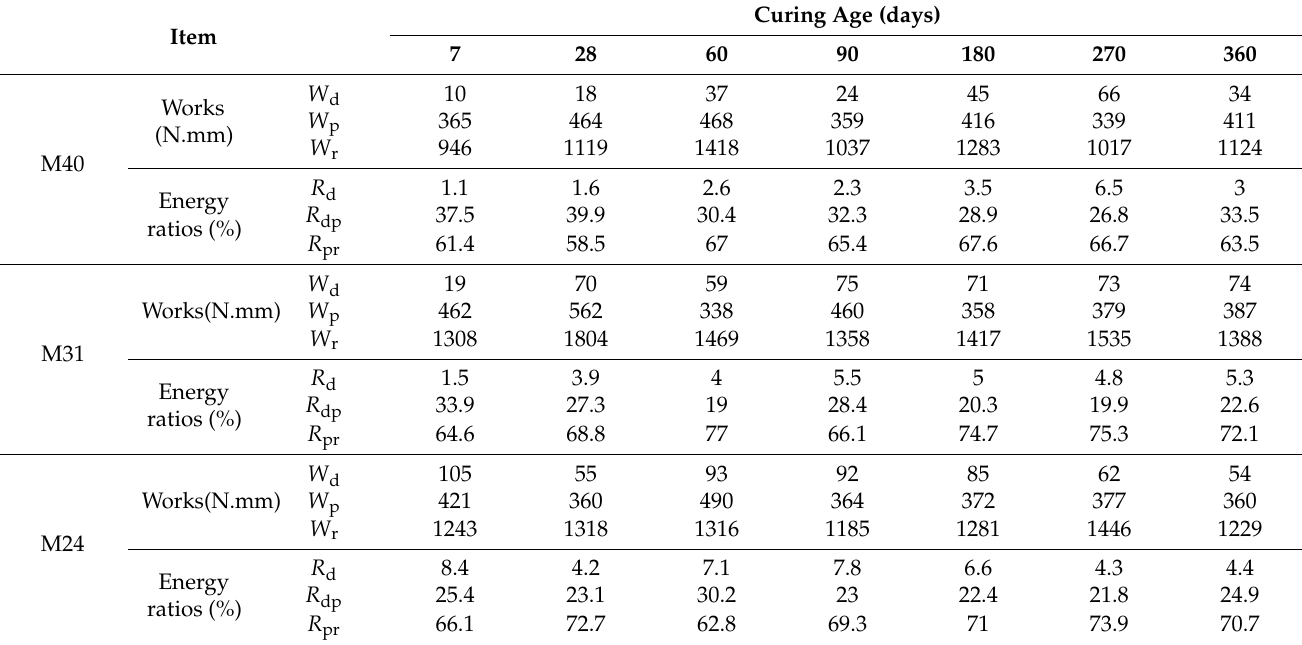
Table 6. Energy dissipation in the process of pull-out